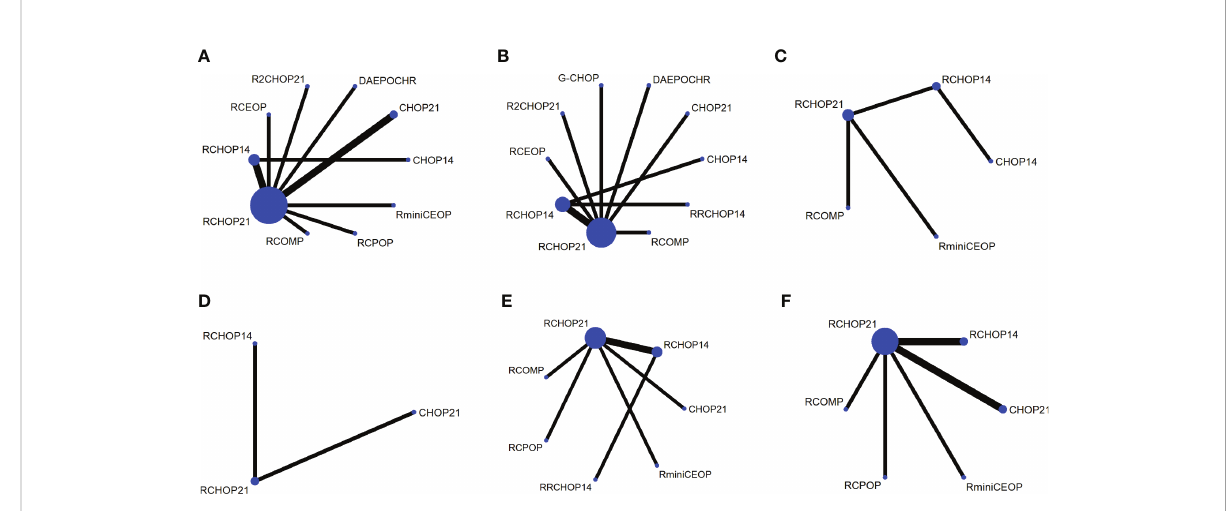
FIGURE 1 Network plot for each of the different outcomes assessed (A) OS, (B) PFS, (C) EFS, (D) DFS, (E) CR, (F)